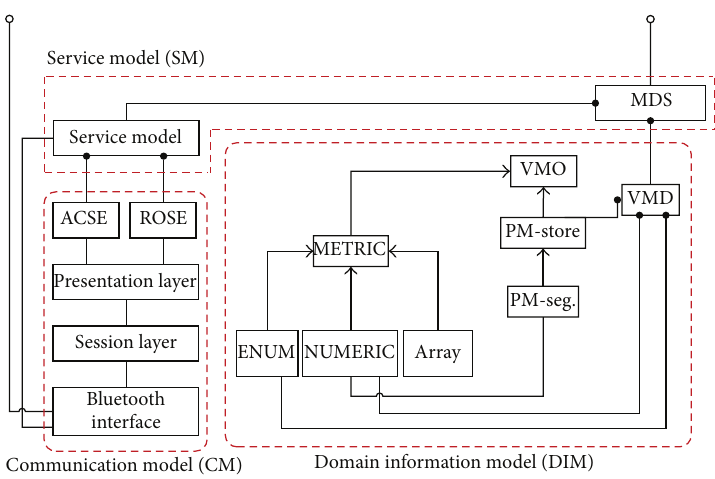
Figure 10: The relationship between DIM, SM, and CM in the middleware.